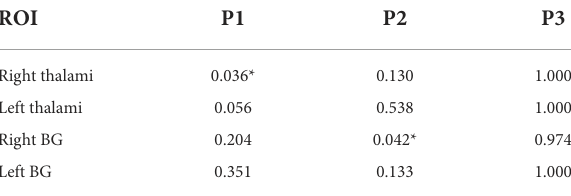
TABLE 5 Subgroup comparison results in the post-hoc analysis (Bonferroni